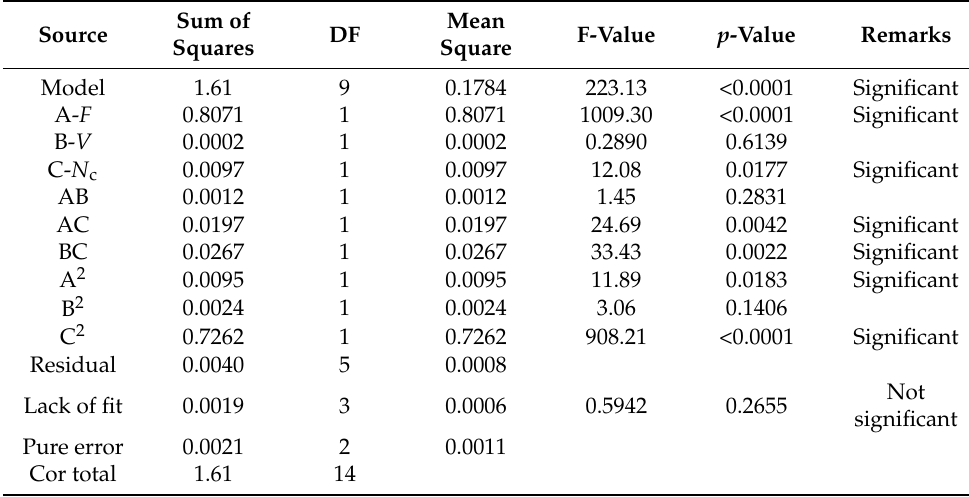
Table 8. ANOVA table of R a value for nanofluids.